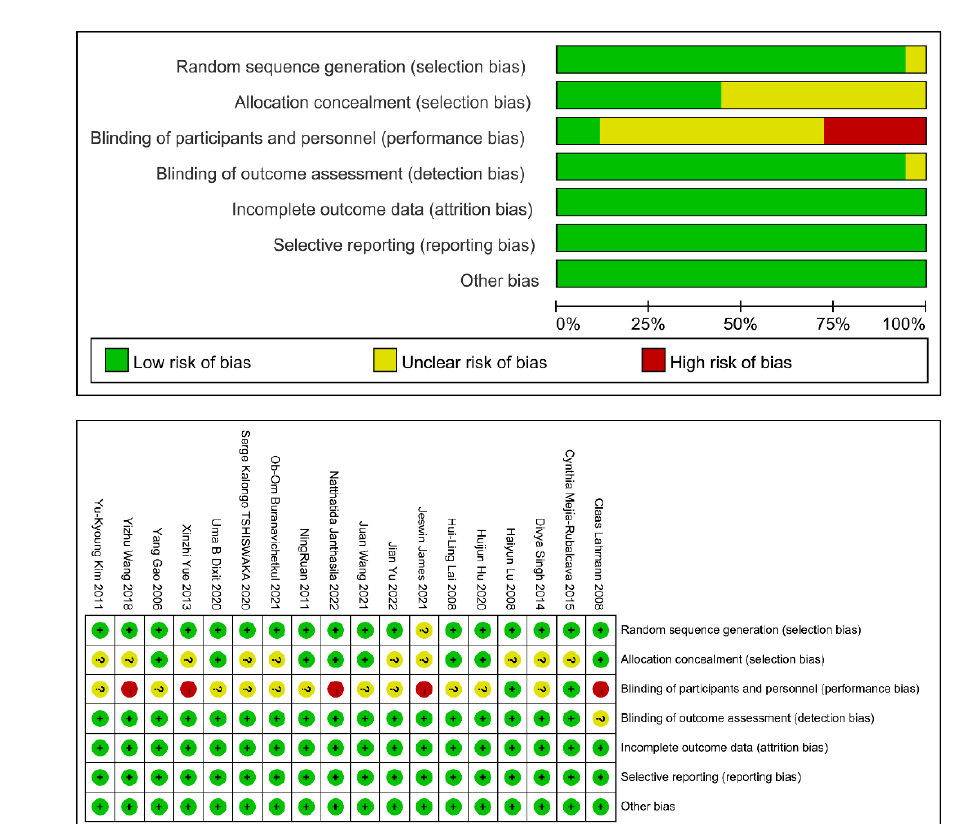
Figure 2. Risk bias assessment of the included studies [17 – 34].